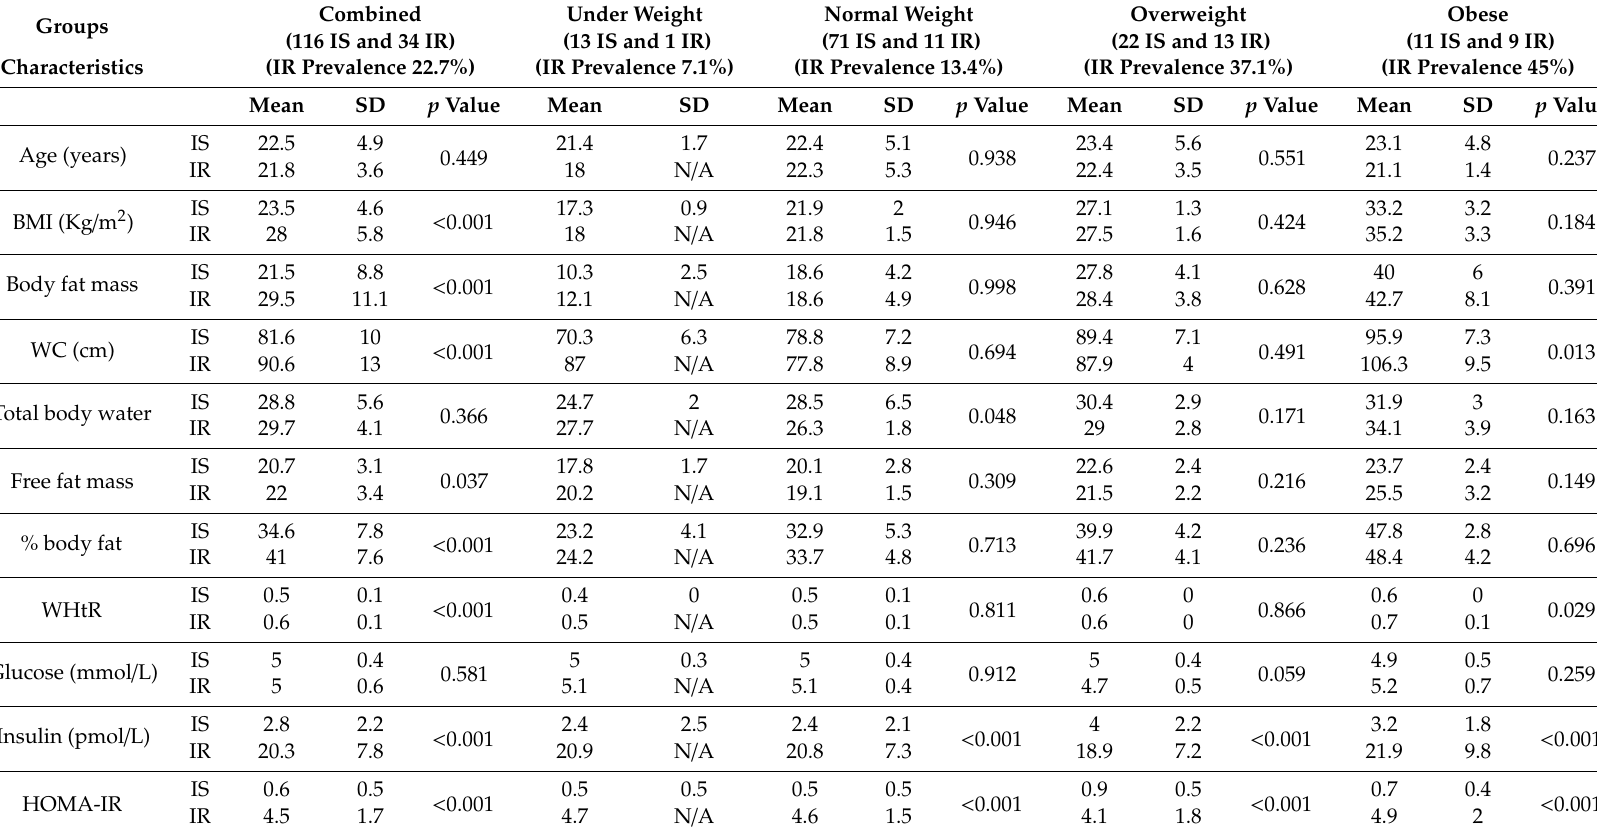
Table 1. General characteristics of study participants divided into underweight, normal weight, overweight and obese insulin sensitive (IS) and insulin resistant (IR) participants. Combined Under Weight Normal Weight Overweight Obese Groups (116 IS and 34 IR) (11 IS and 9 IR) Characteristics